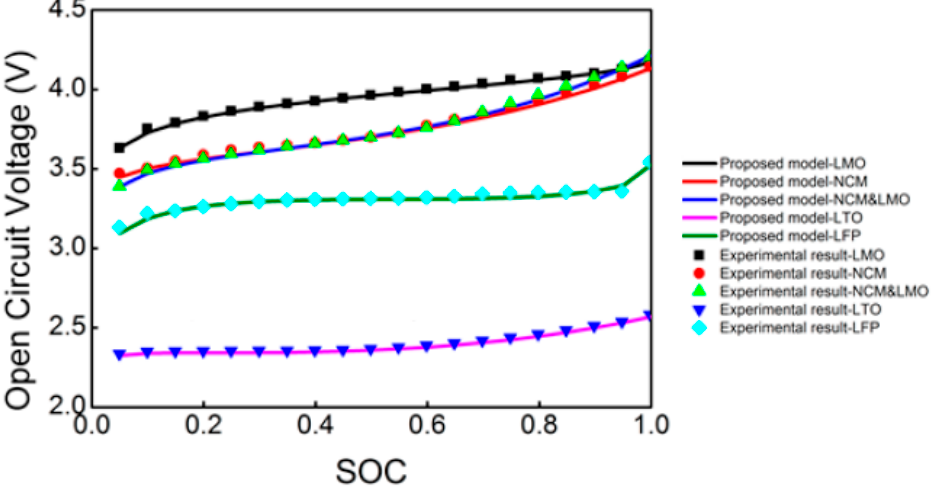
Figure 5. The estimated and experimental OCV curves for different Li-ion batteries: LiMn 2 O 4 (LMO), Li(Ni x Mn y Co 1 − x − y )O 2 (NCM or LNMCO), NCM&LMO, LiTi 5 O 12 (LTO), LiFePO 4 (LFP) [103].